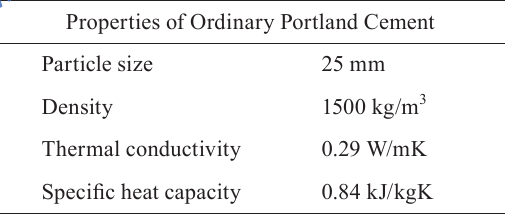
Table 1 Properties of Granular Material Properties of Ordinary Portland